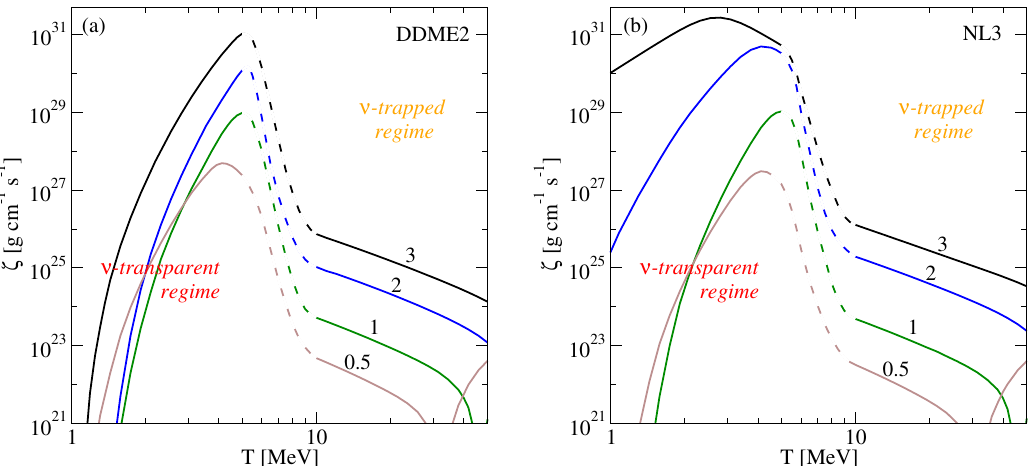
Figure 6. The bulk viscosity as a function of temperature for several values of the baryon density marked on the plots for ( a ) model DDME2; ( b ) model NL3. In the temperature range 5 10MeV the bulk viscosity is obtained by interpolating between the results of neutrino-transparent and neutrino-trapped matter. The oscillation frequency is fixed at f = 1 kHz, and the lepton fraction is fixed at Y L =